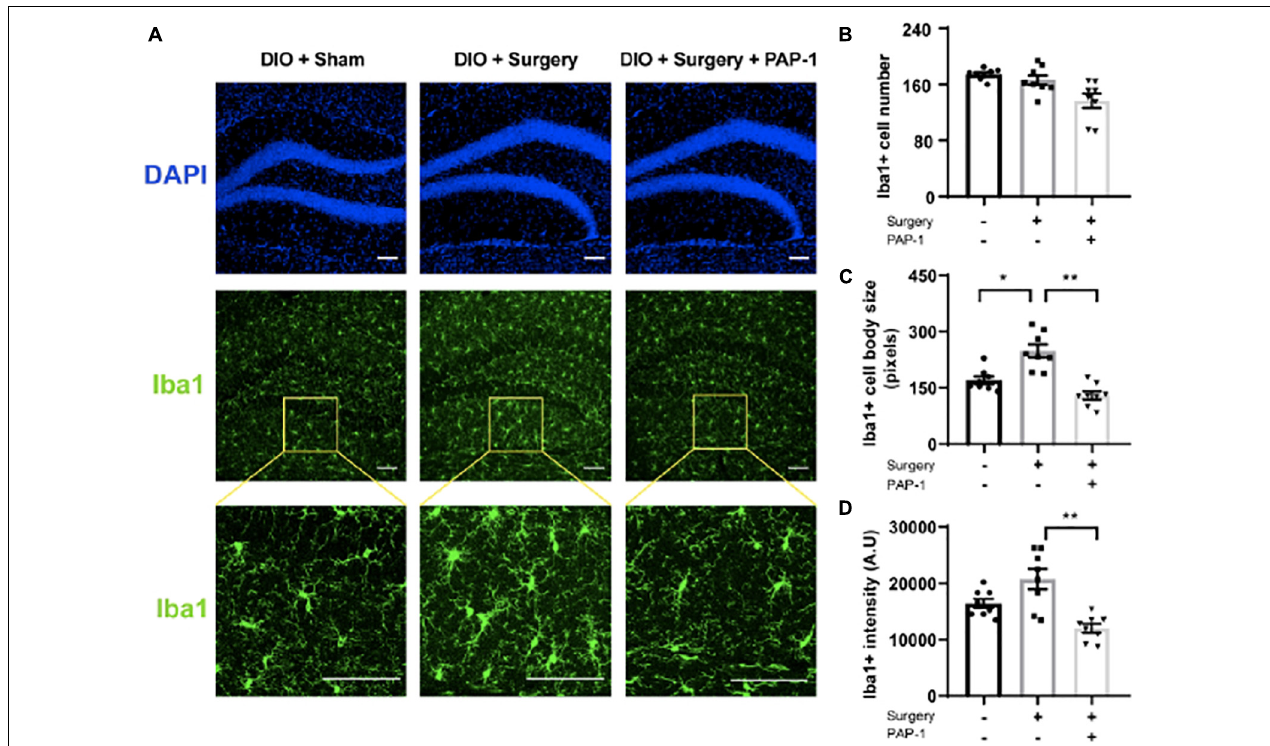
FIGURE 5 | Phenoxyalkoxypsoralen-1 (PAP-1) attenuates surgery-induced microglial activation. Applied for Permission to Reproduce Ieng et al. (2020). Mice with diet-induced obesity (DIO) were randomized to three groups ( n = 8 per group) that received neither surgery nor PAP-1 (DIO/sham), surgery alone with no PAP-1 (DIO/surgery), or surgery together with PAP-1 (DIO/surgery/PAP-1). After surgery, mice not randomized to receive PAP-1 (DIO/sham; DIO/surgery) were administered MIGLYOL, and mice randomized to PAP-1 received doses intraoperatively and 12 h postoperatively. At 24 h after surgery, mice were killed, and brains were perfused, fixed, and sectioned. Coronal sections (35 mm thick) from the dentate gyrus were stained with anti-Iba1 antibody. Immunofluorescence was performed with Alexa Fluor 488-labeled anti-rabbit antibody. (A) Representative photomicrographs from each of the groups. The upper panel represents DAPI staining, the middle panel staining for Iba1, and the lower panel a higher magnification. The internal scale marker represents 50 mm. (B) Iba1cells were counted manually by visual inspection of hippocampal sections of anatomically matched photomicrographs, with an average taken from four sequential sections per mouse. (C) To analyze microglial cell-body size (in pixels), each section was processed in a systematic way to create a binary image by applying a previously established threshold. (D) Iba1 fluorescence intensity [absorbance unit (AU)] was similarly measured with ImageJ from images captured using identical exposure times that also avoided saturating pixel intensities. Data [mean (standard deviation)] were analyzed by one-way analysis of variance followed by Bonferroni post hoc test. *P1/40.0012; ** P < 0.001 (Ieng et al.,